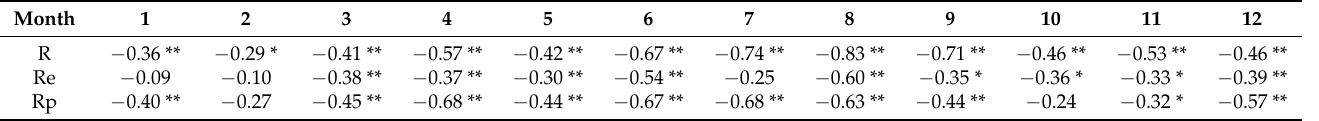
Table 3. Correlation coefficients between precipitation and Epan on the TP at the monthly scale.